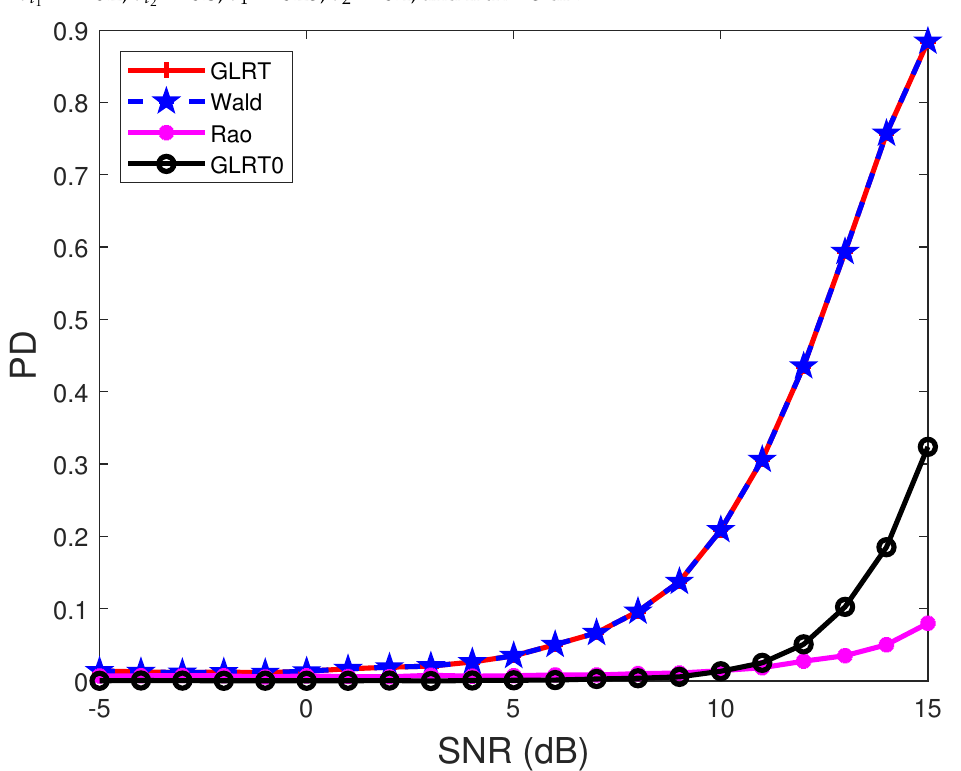
Figure 2. PDs of the detectors under different SNRs. R ( i 1 , i 2 ) = 0.95 | i 1 − i 2 | , N = 8, p = 2, M = 2 N , = − 0.2, θ t = 0.3, θ = 0.25, θ = 0.4, and INR = 5 dB. θ t 2 1 2 1